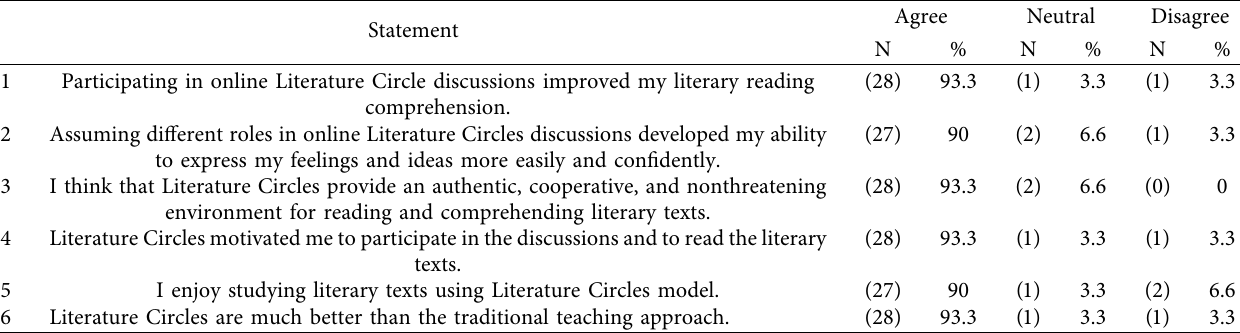
Table 5: Frequencies and percentages of students’ responses to the use of Literature Circles 2.0 in studying literary texts.